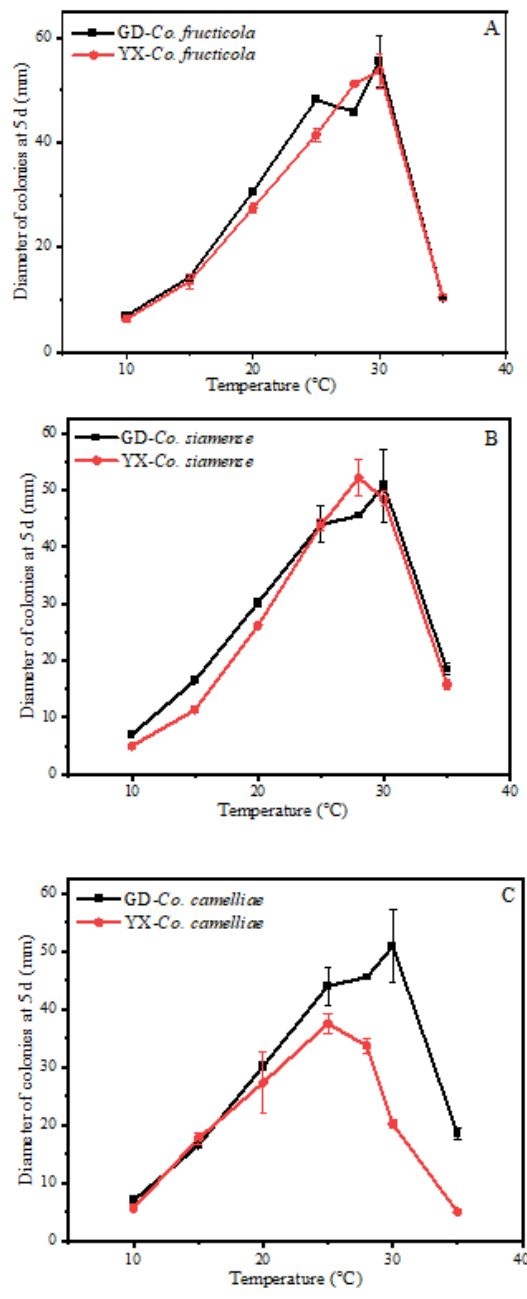
Figure 6. Effect of temperature on the growth of ( A ) YX- Co . fructicola (YX2-5-2) and GD- Co . fructicola ; ( B ) YX- Co . siamense (2YX-8-1-1) and GD- Co . siamense ; ( C ) YX- Co . camelliae (2YX-5-1) and GD- Co . camelliae . The error bars represent standard deviations based on three biological replicates. Table 3. Optimum mycelial growth temperature of the six isolates. Isolates Optimal Temperatures ( ◦ C) YX- Colletotrichum spp.